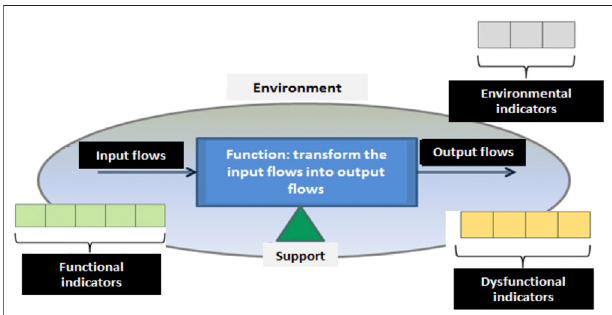
FIGURE 3 | Health checkup associated systemic representation of a